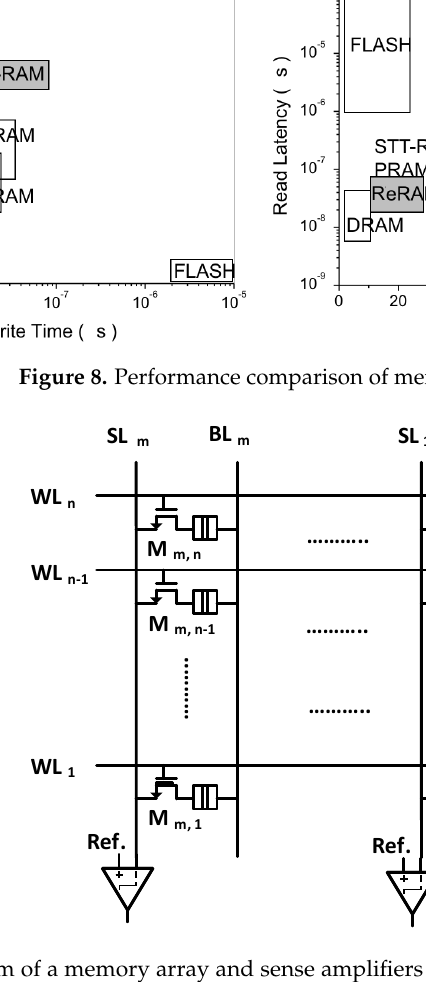
Figure 9. Block diagram of a memory array and sense amplifiers with a variable reference to perform a logic